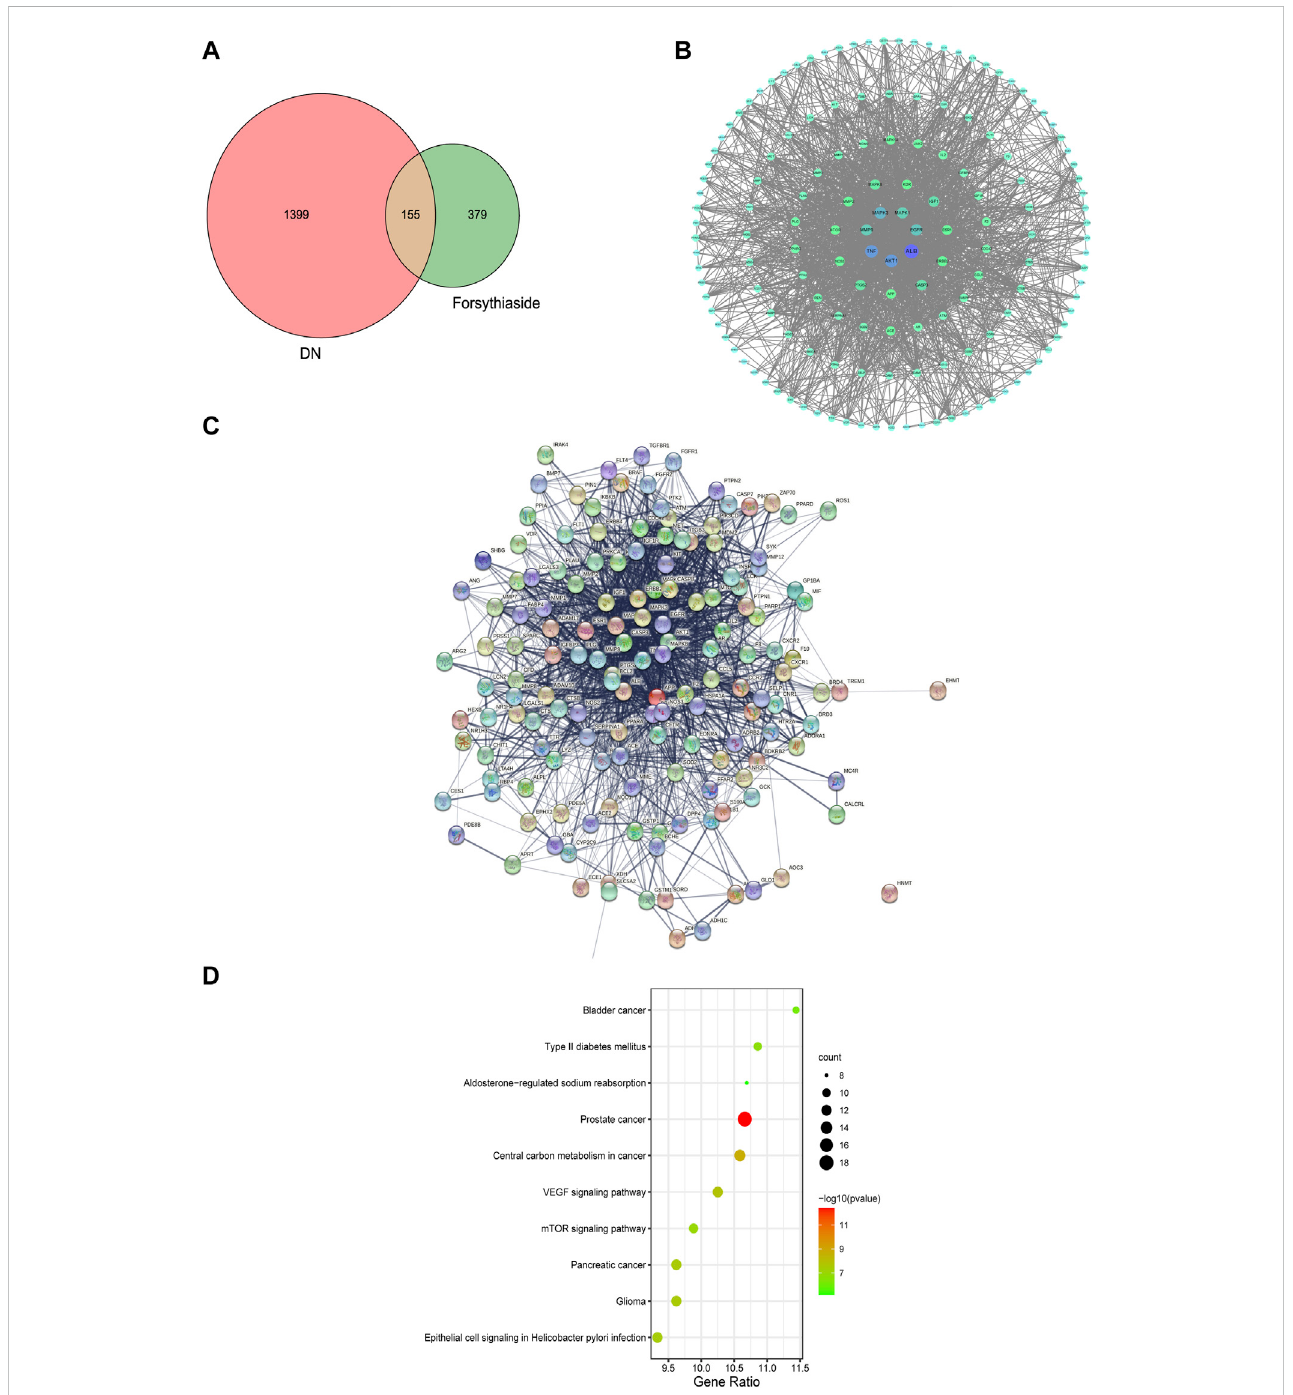
FIGURE 3 Venn diagram, PPI network and KEGG enrichment of Forsythiaside-DKD targets. (A) Venn diagram of overlapping targets of Forsythiaside and DKD. (B) PPI network of Forsythiaside-DKD targets. A total of 155 overlapping targets were presented as circle and ordered by the degree level. The hub targets were presented in the innermost center circle, and the core targets were AKT1, ALB, TNF, MAPK3, MAPK1, MMP9, and EGFR. (C) The interactive relationship was analyzedanddisplayedasPPInetworkbySTRINGwebsite. (D) KEGGenrichmentanalysisofpotentialtargetsthatForsythiasideactedforalleviatingDKD. DKD: diabetic kidney